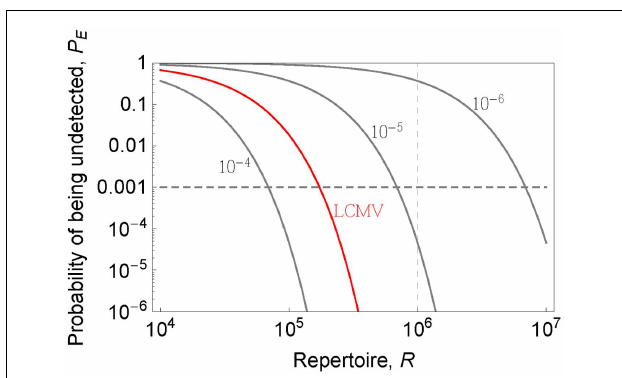
FIGURE 4 | Probability that a pathogen is not recognized P E (y-axis) is plotted as a function of the repertoire (x-axis) for indicated pathogen-specific precursor frequencies (gray lines) . LCMV case ( p = 4 × 10 − 5 ) is shown in red